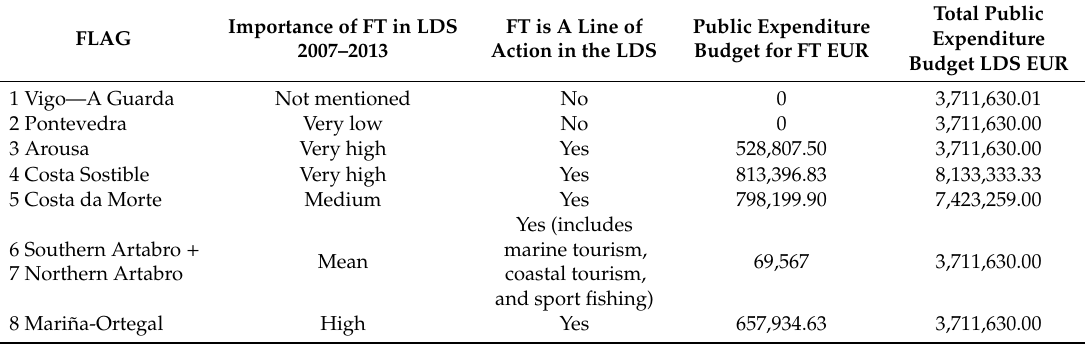
Table 2. Fishing tourism (FT) in local development strategy (LDS) by Fisheries Local Action Groups (FLAGs)